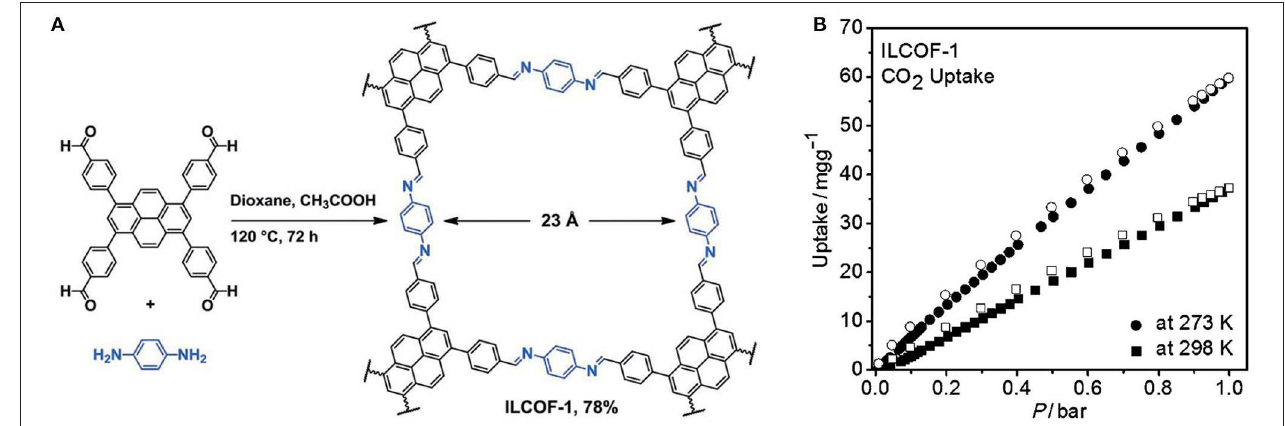
FIGURE 2 | (A) Structure of ILCOF-1 by synthesized by Rabbani et al. (2013) and (B) CO 2 uptake capacity of ILCOF-1 as measured by Kaderi et al. Reprinted with permission © 2013 Wiley